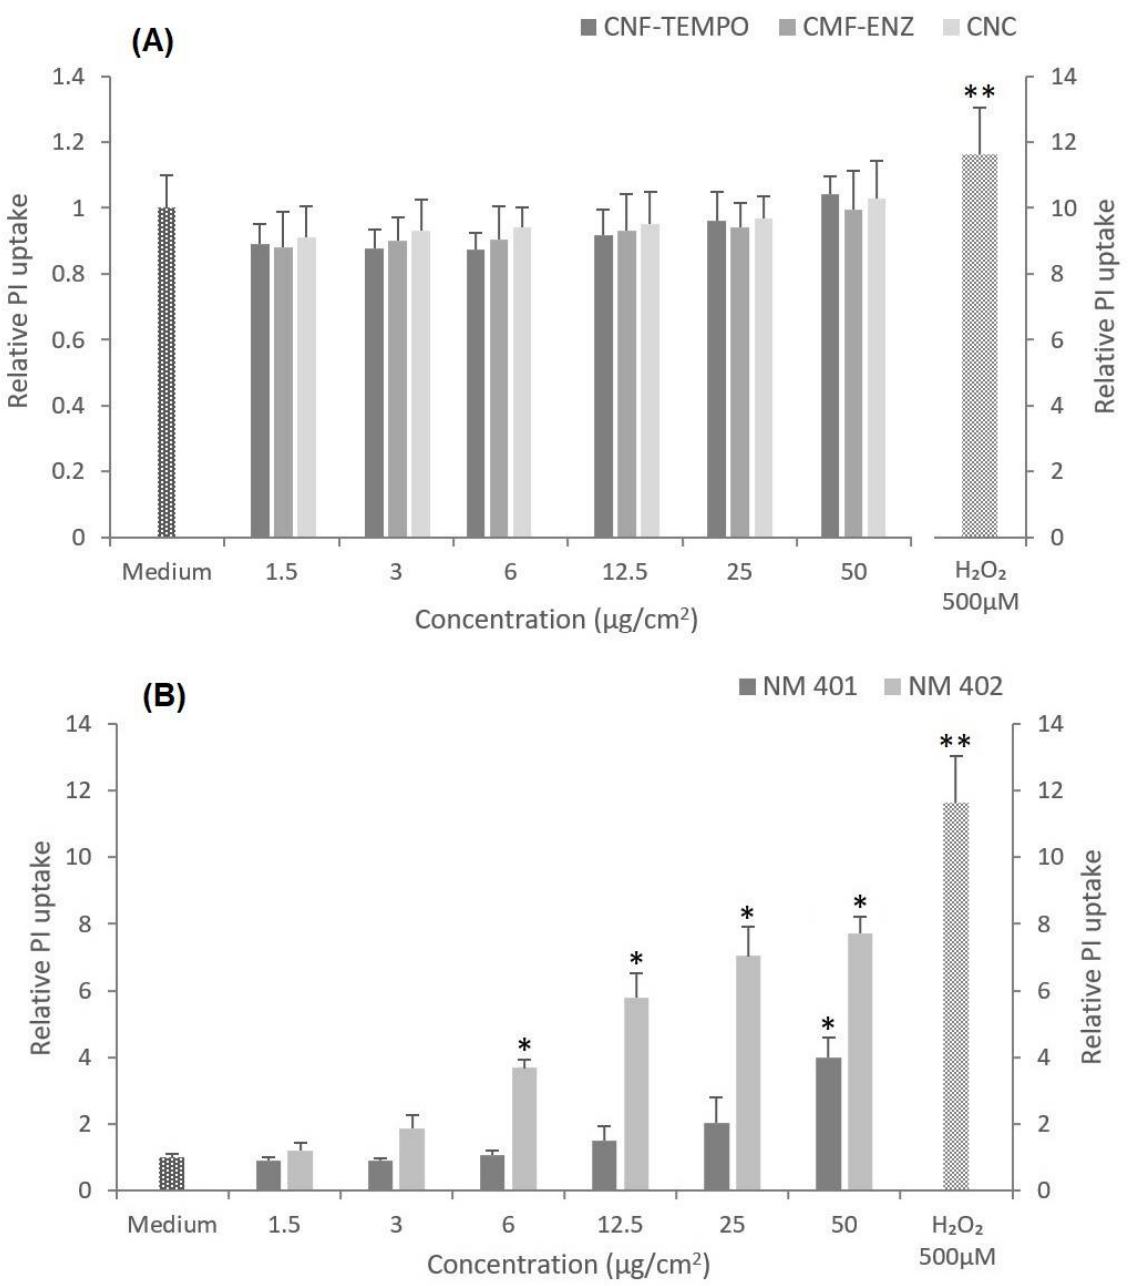
Figure 6. Effects of nanocellulose and MWCNT exposure at different concentrations on the cell viability of A549 cells assessed by the propidium iodide (PI) membrane integrity assay, after 24 h: ( A ) CNF-TEMPO, CMF-ENZ, and CNC; ( B ) NM-401, NM-402. Data are the mean ± SD of three independent experiments. * p < 0.05, ** p < 0.01.